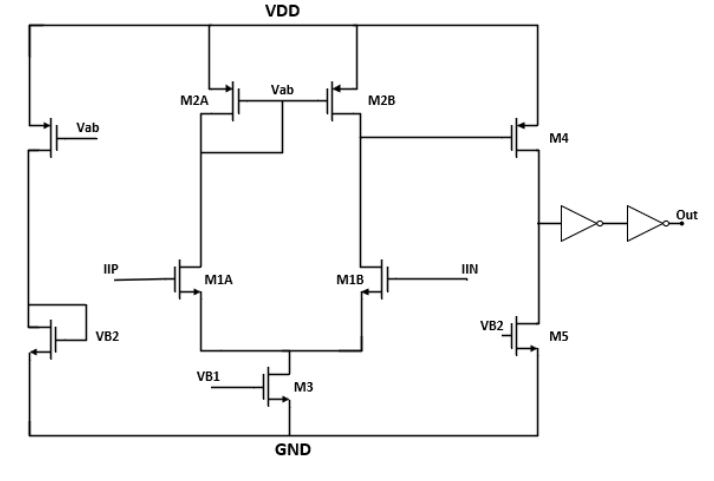
Figure 9. Comparator transistor-level scheme.